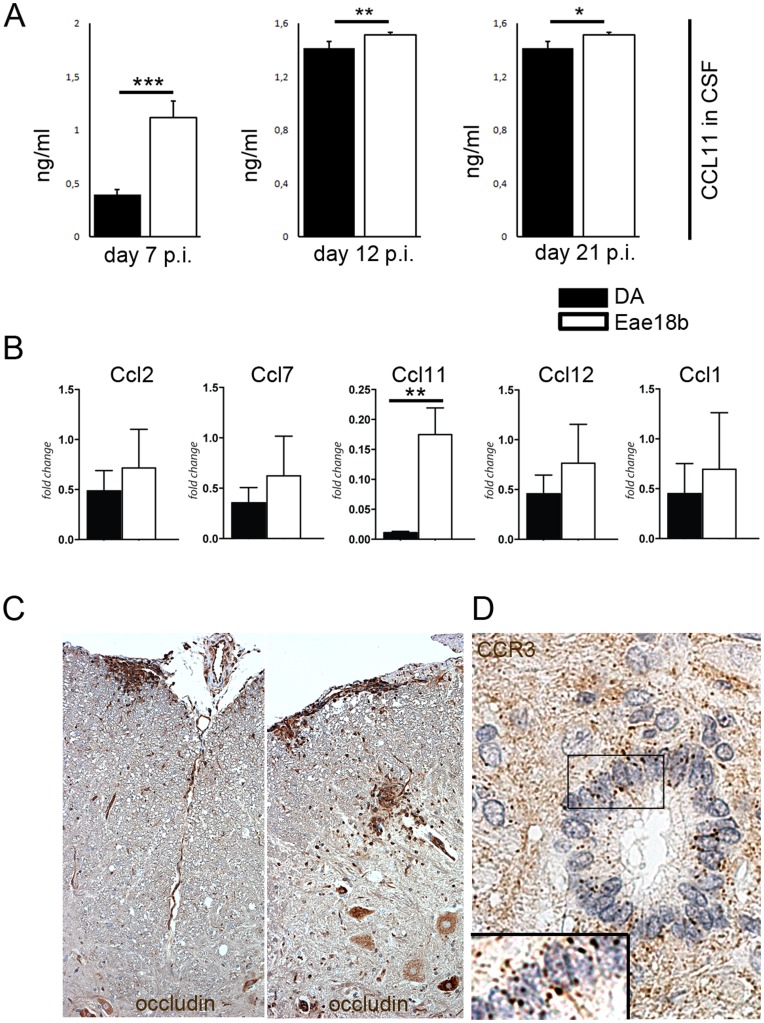

Eae18b regulates intrathecal production of CCL11 and influences the BBB integrity.(A) During the whole disease course CCL11 protein levels were increased in the cerebrospinal fluid (CSF), in the congenics (Eae18b) compared to controls (DA). Experiments repeated twice, three to five animals per group analyzed. (B) mRNA levels of Ccl11 measured in the late disease time point (day 23 p.i.) showed upregulation in the congenic spinal cord. Error bars represent SEM, and (*) indicates p-value <0.05, (**) indicates p-value <0.01, (***) indicates p-value <0.001 calculated by Student’s t-test in (A) and by Mann-Whitney non-parametrical test in (B). (C) Representative images of occludin, a marker for the BBB tight junction components; more abundant in the congenic spinal cord (cross sections of seven congenic and eight control animals analyzed on day 12 p.i.). (D) Representative image of CCR3, the main receptor for CCL11, expressed on ependymal cells of the spinal cord canalis centralis, including a detail in high magnification (160×). Five congenic and four control animals analyzed on day 15 p.i.